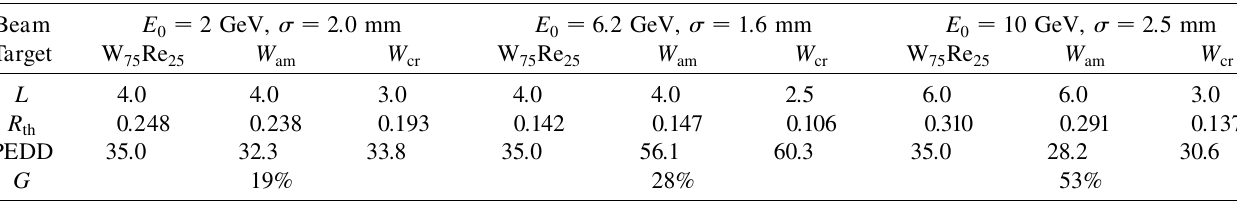
TABLE I. Energy deposition in crystal and amorphous targets. The fraction of an incident beam power deposited in a target, (cid:9) P =P R ; the peak energy deposition density, PEDD, in units of J = g ; the energy, E th dep 0 (cid:15) ; target thickness, L , measured in conventional radiation lengths, X and W 100 , from comparison of W cr am